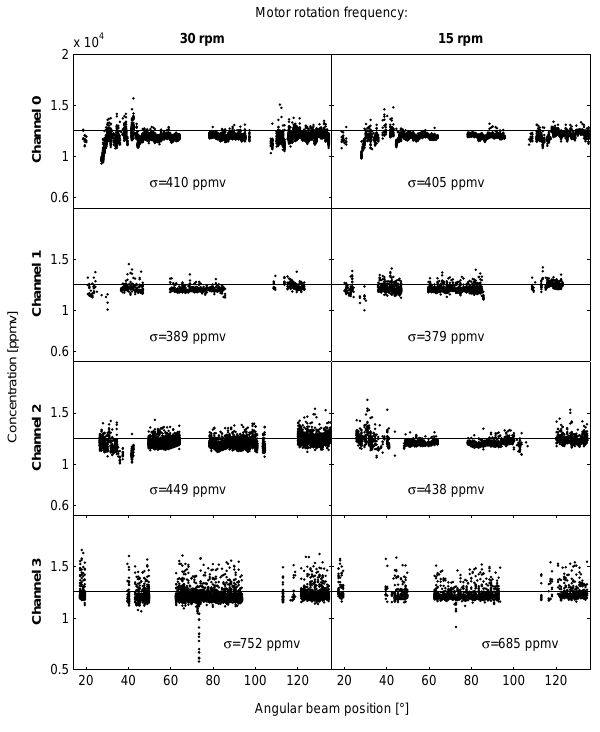
Figure 4. H 2 O concentrations measured with continuously scan- ning spectrometer for different polygon mirror rotation speeds. Channel 0 to Channel 3 depict the four scanning/receiver units. In the left column, results are shown that were recorded at 30rpm motor rotation frequency, which leads to a 2-D-H 2 O-field rate of 2.5Hz. In the right column, the motor rotation frequency amounted 15rpm, corresponding to 1.25Hz field rate. The solid lines show the average H 2 O concentration measured with the bi-static TDLAS reference spectrometer ( c Ref ) . At some angular positions, no evalu- ation of the detected signal could take place. This is due to very poor reflection of the laser light while the beam is moving across oppo- site scanning units or in instances when the light incidence angle onto the foil is too